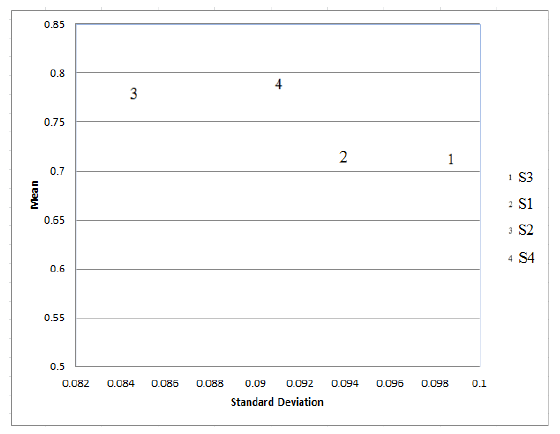
Figure 14. Mean value of performance of all classifiers (impact) for each scenario and deviation of scenarios from their impact using all